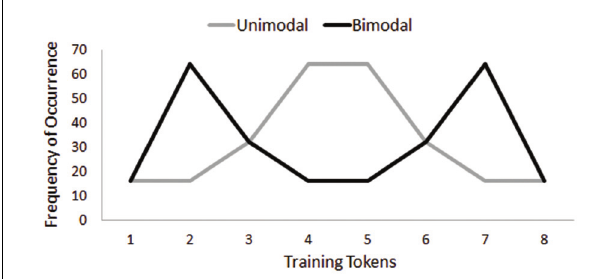
FIGURE 1 | Frequency of occurrence for each training token heard by the Unimodal condition and the Bimodal